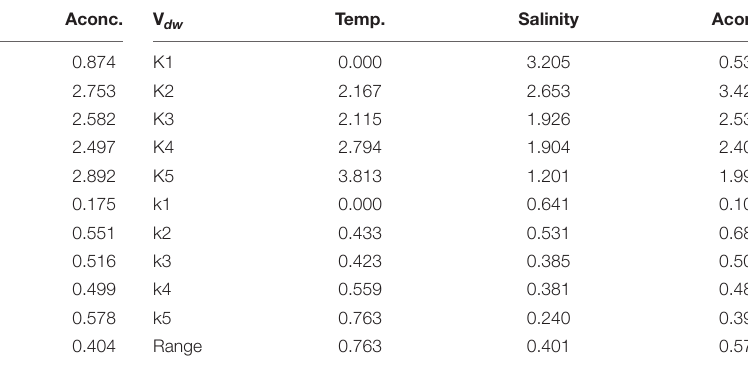
TABLE 7 | NaOH V dw orthogonal data processing. TABLE 8 | Na 2 CO 3 V do orthogonal data